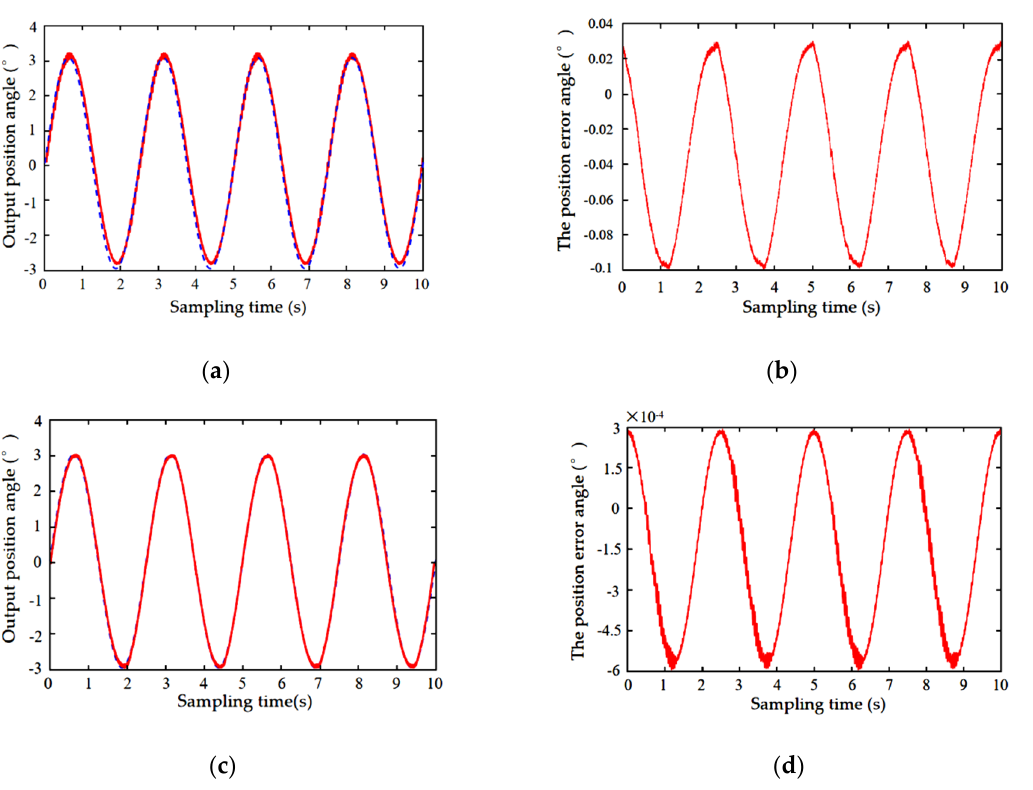
Figure 15. Result of model control in the course of the experiment. ( a ) Sin position actual output for PID control; ( b ) position error; ( c ) sin position actual output under compensated control by the LuGre friction model with piecewise parameter identification by GA-PSO; ( d ) position error under compensated control by the LuGre friction model with piecewise parameter identification by GA-PSO.